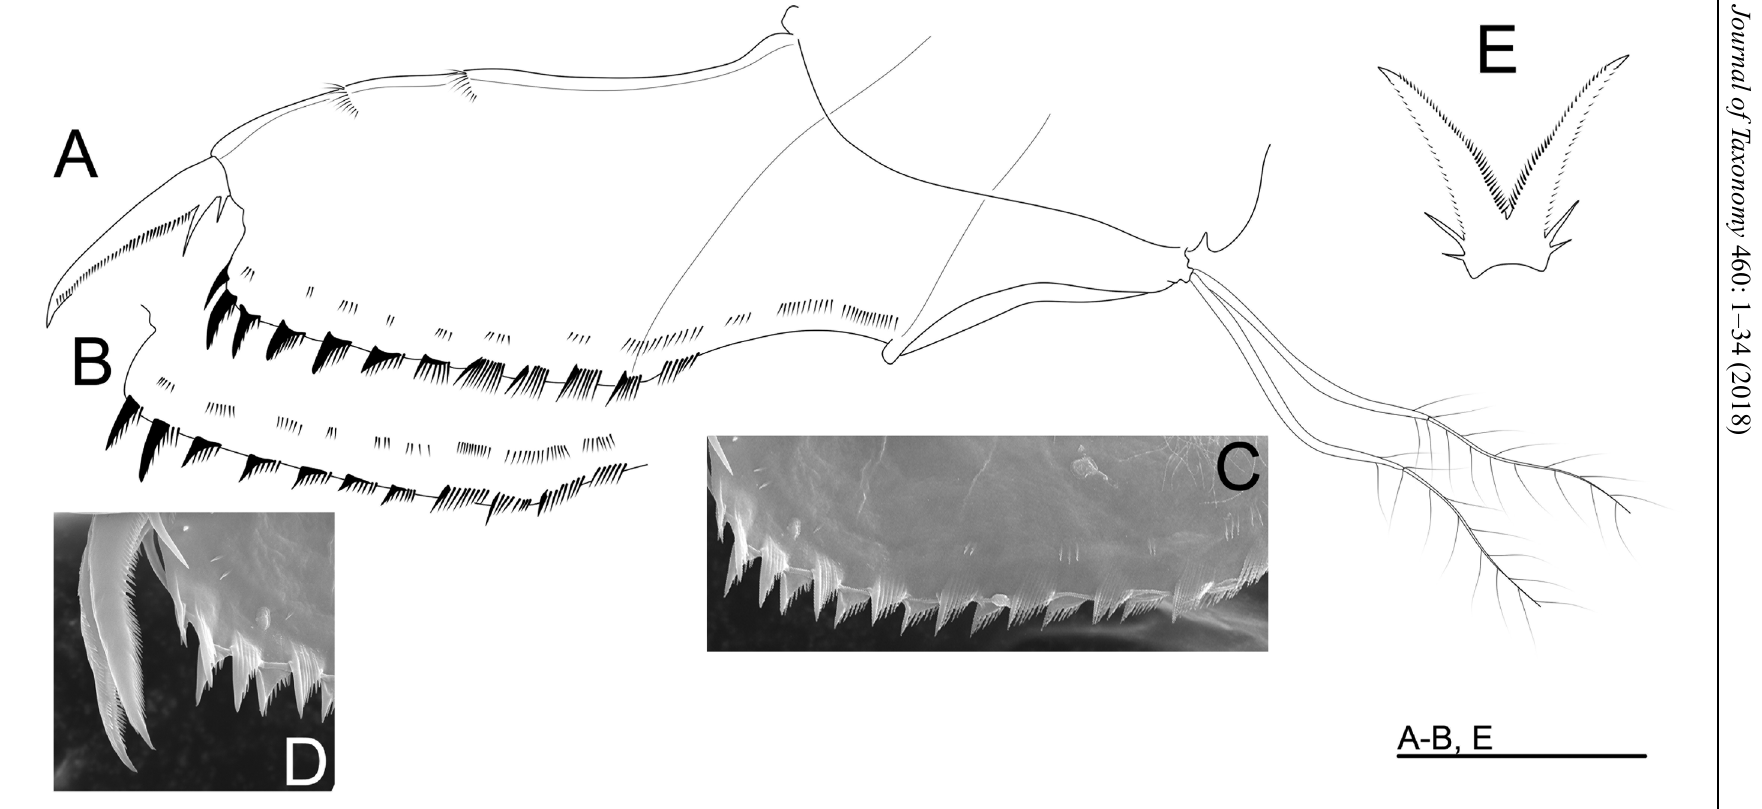
Fig. 9. Disparalona ( Mixopleuroxus ) lucianae sp. nov., parthenogenetic female. A–E . Postabdomen. A . Lateral view. B–D . Marginal denticles. E . Dorsal view of postabdominal claw (separation between claws not represented). Scale bar = 50 μm. Figs C–D were not